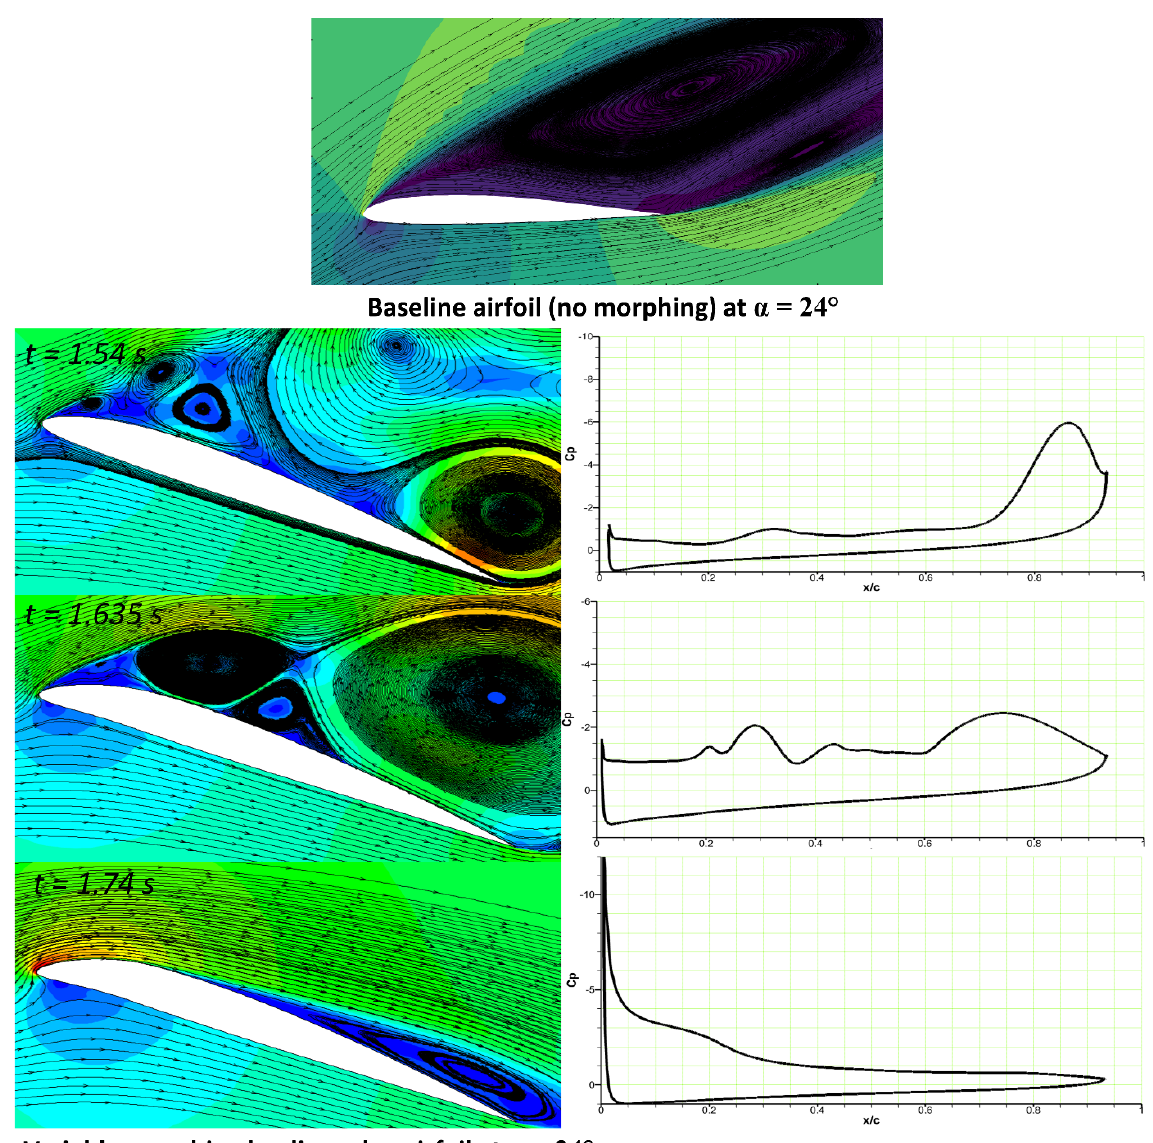
Figure 15. Streamlined velocity contours at time step of t = 0.53 s on a variable morphing leading edge and the Cp distribution at 24° angle of attack.